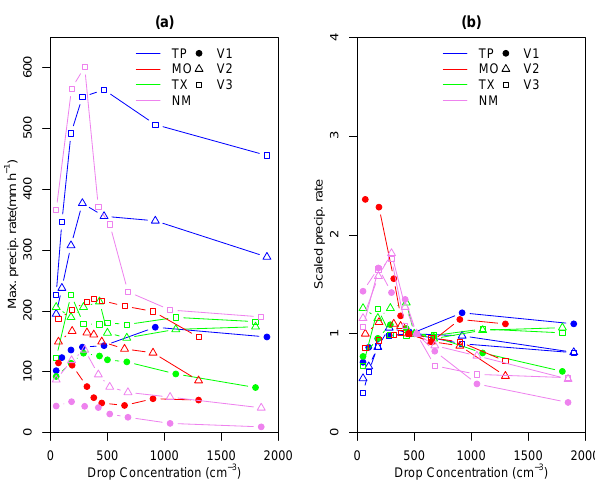
Fig. 5. Dependence of maximum precipitation intensity on location, cloud vigor and aerosol (cloud drop number). (a) Absolute precipitation rates. (b) Precipitation rates scaled to values at 500cm − 3 to show relative changes.